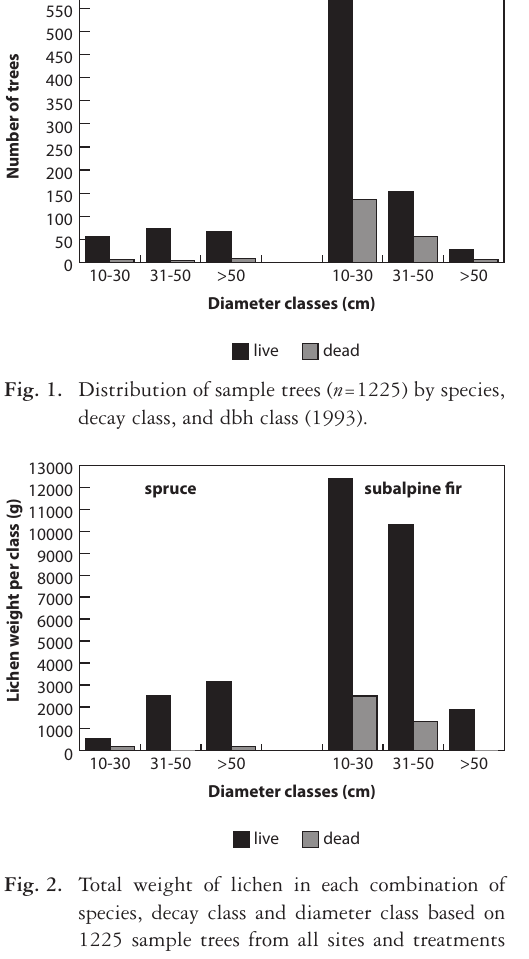
Fig. 6. The percentage of sample trees that showed an increase or decrease or no change in lichen abun- dance from 1993 to 2003 (percentages differed significantly among treatments, P =0.03).